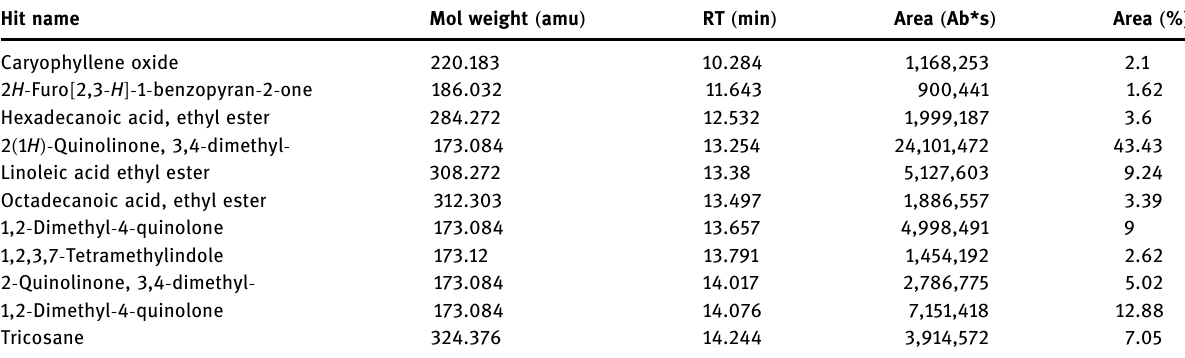
Table 1: GC – MS data of ethanol extract